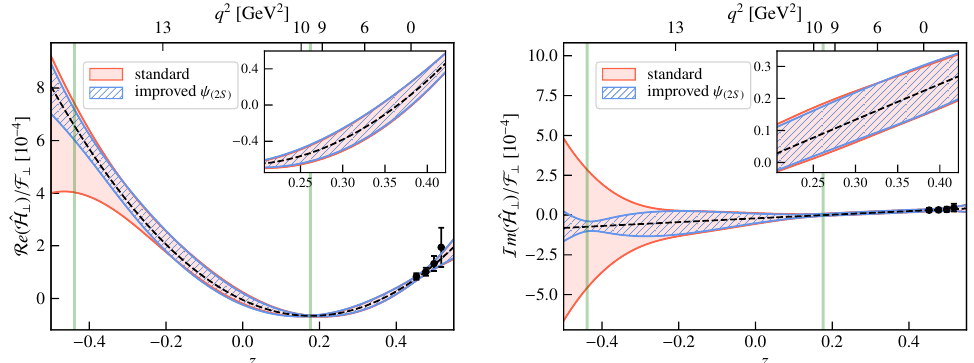
Figure 3 . Results of the (cid:12)ts for the ratios ^ H ? ( z ) = F ? ( z ) obtained with the current status of the theoretical and experimental knowledge and assuming future improvements on the B ! K (cid:3) (2 S ) measurements. Fits correspond to the BMP scenario, the expected statistics at LHCb Upgrade [50 fb (cid:0) 1 ] and to z 4 truncation in the series expansion. The vertical bands correspond to the J= and (2 S ) regions; the points to the theoretical inputs at negative q 2 . The top right box of each plot zooms in the q 2 range between 1.1 and 9.0 GeV 2